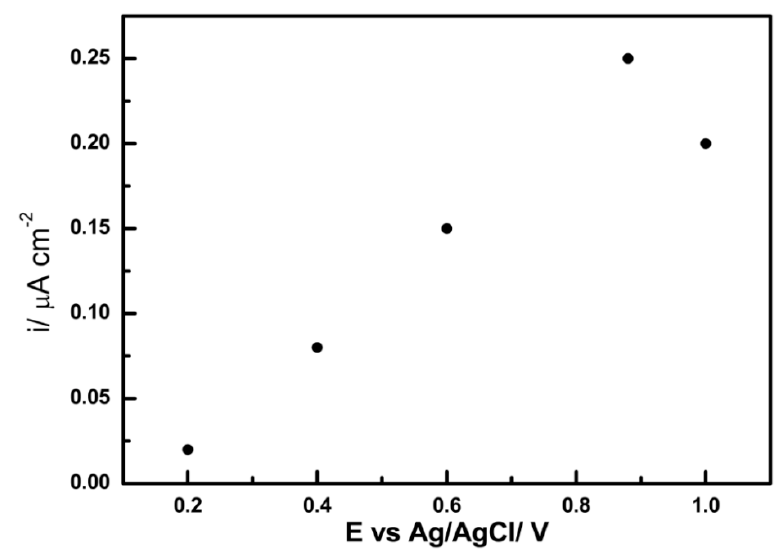
Figure 9. The dependence of chronoamperometric steady current response on the applied potential. Table 1. Prussian blue (FeFCF) and its analog-based adsorbents for cesium removal.